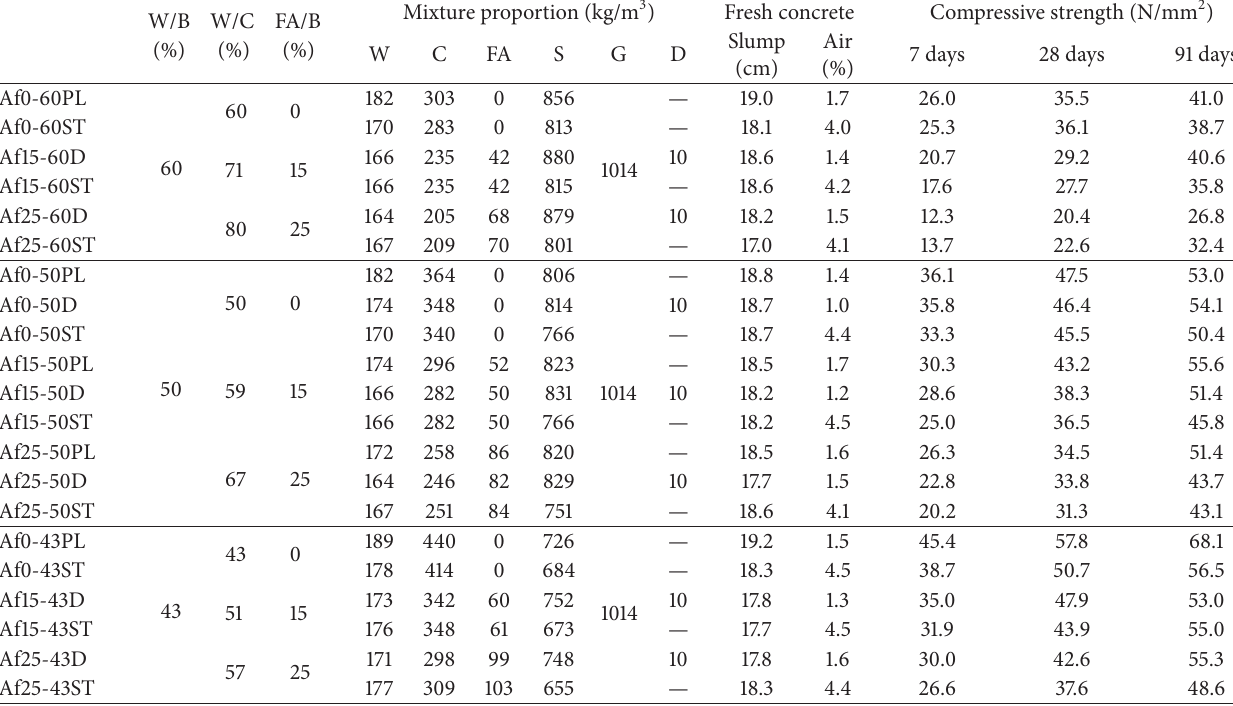
Table 4: Mixture proportion and properties of fresh and hardened concrete.